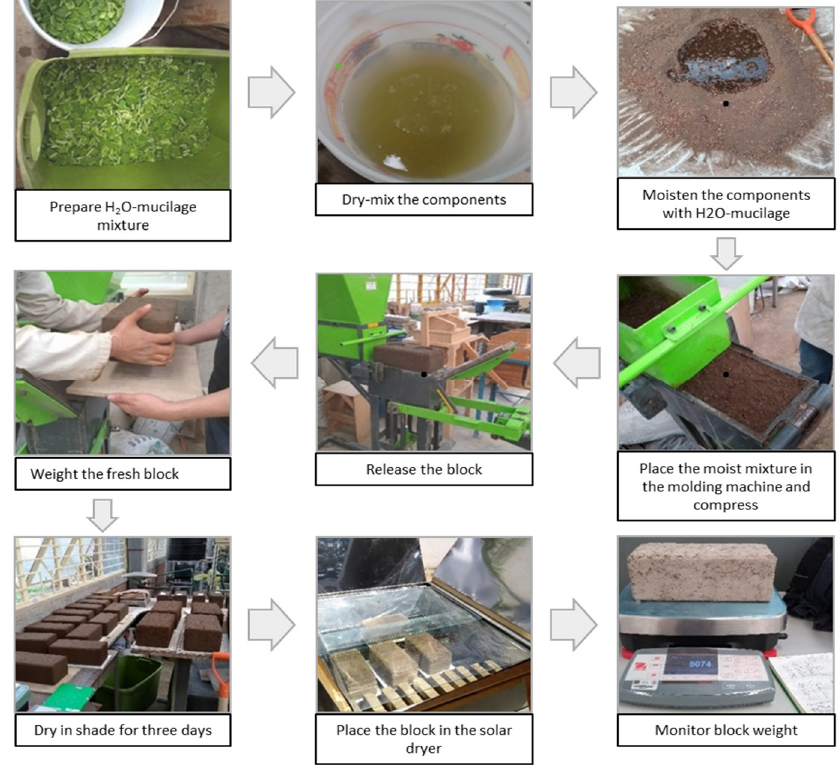
Figure 1. Block making procedure.